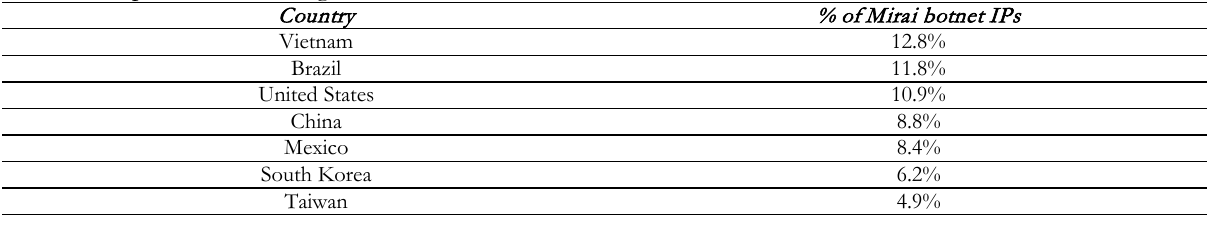
Table 1. Top countries of origin of Mirai DDoS attacks